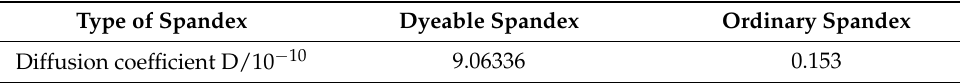
Table 3. Diffusion coefficient of spandex dyed with neutral red G. Type of